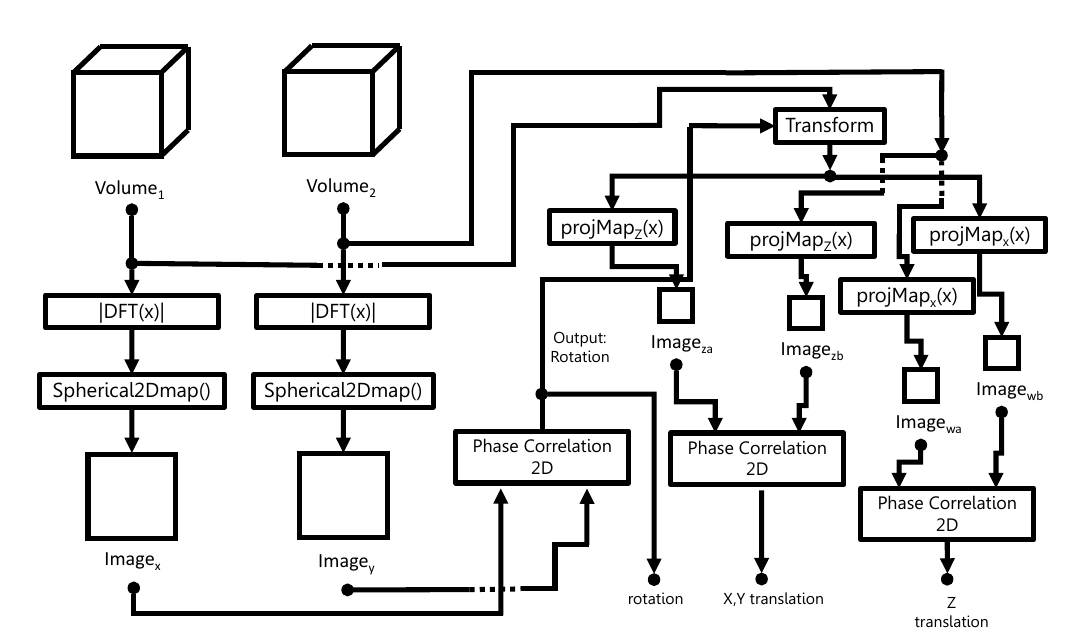
Figure 2. System Diagram for Fast Volume